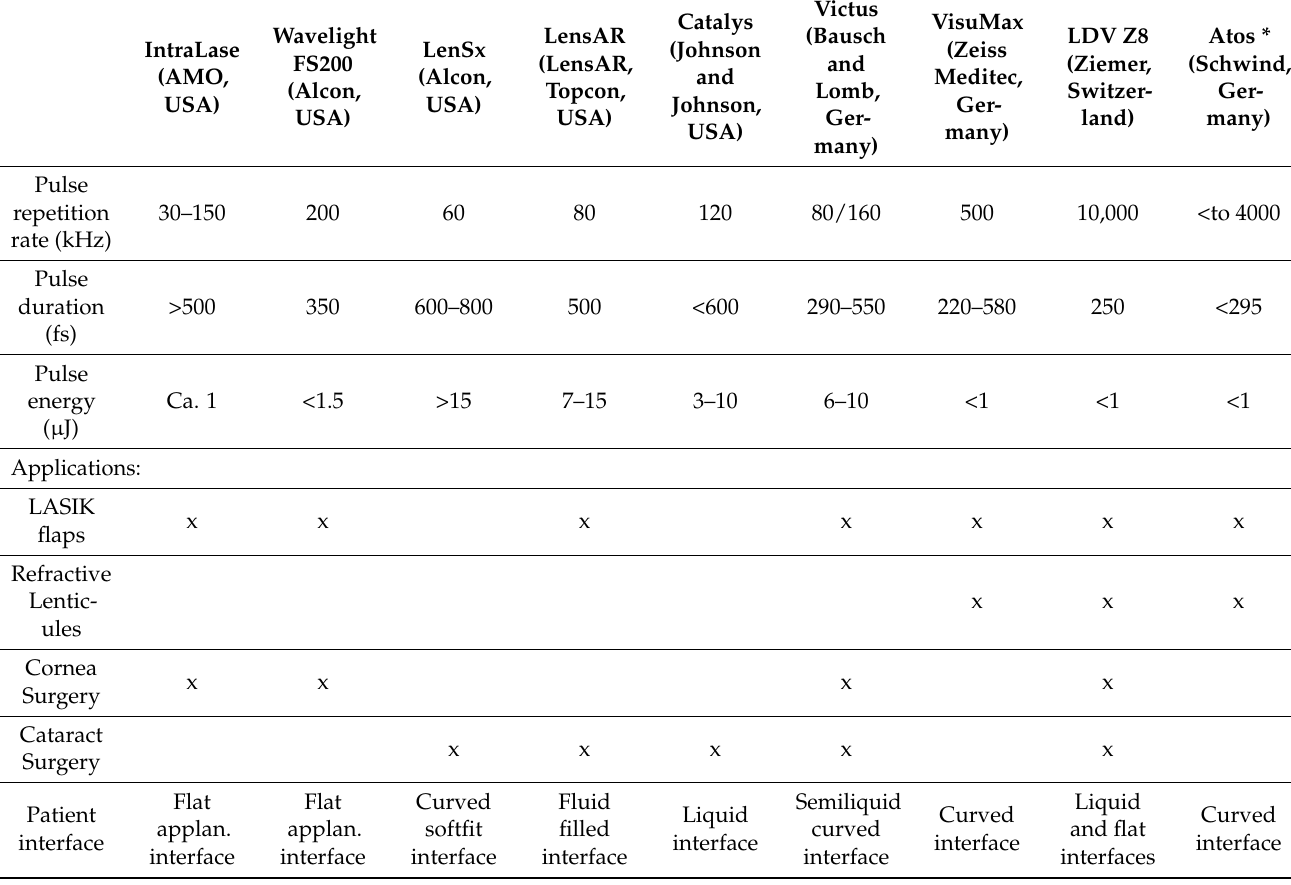
Table 1. Overview of five commercially available femtosecond lasers for eye